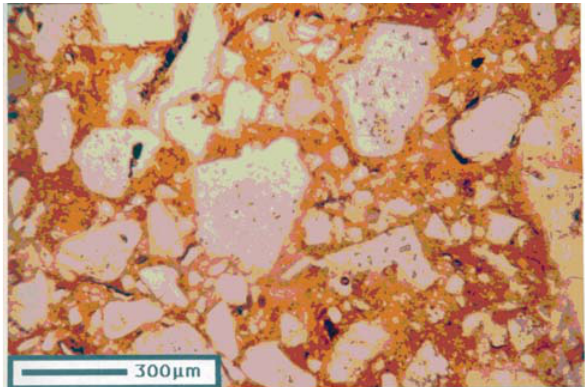
Figura 5. Micrografia do horizonte Bt do perfil 2 em plano polarizado (PPL). Frações grosseiras totalmente embebidas em um plasma bastante